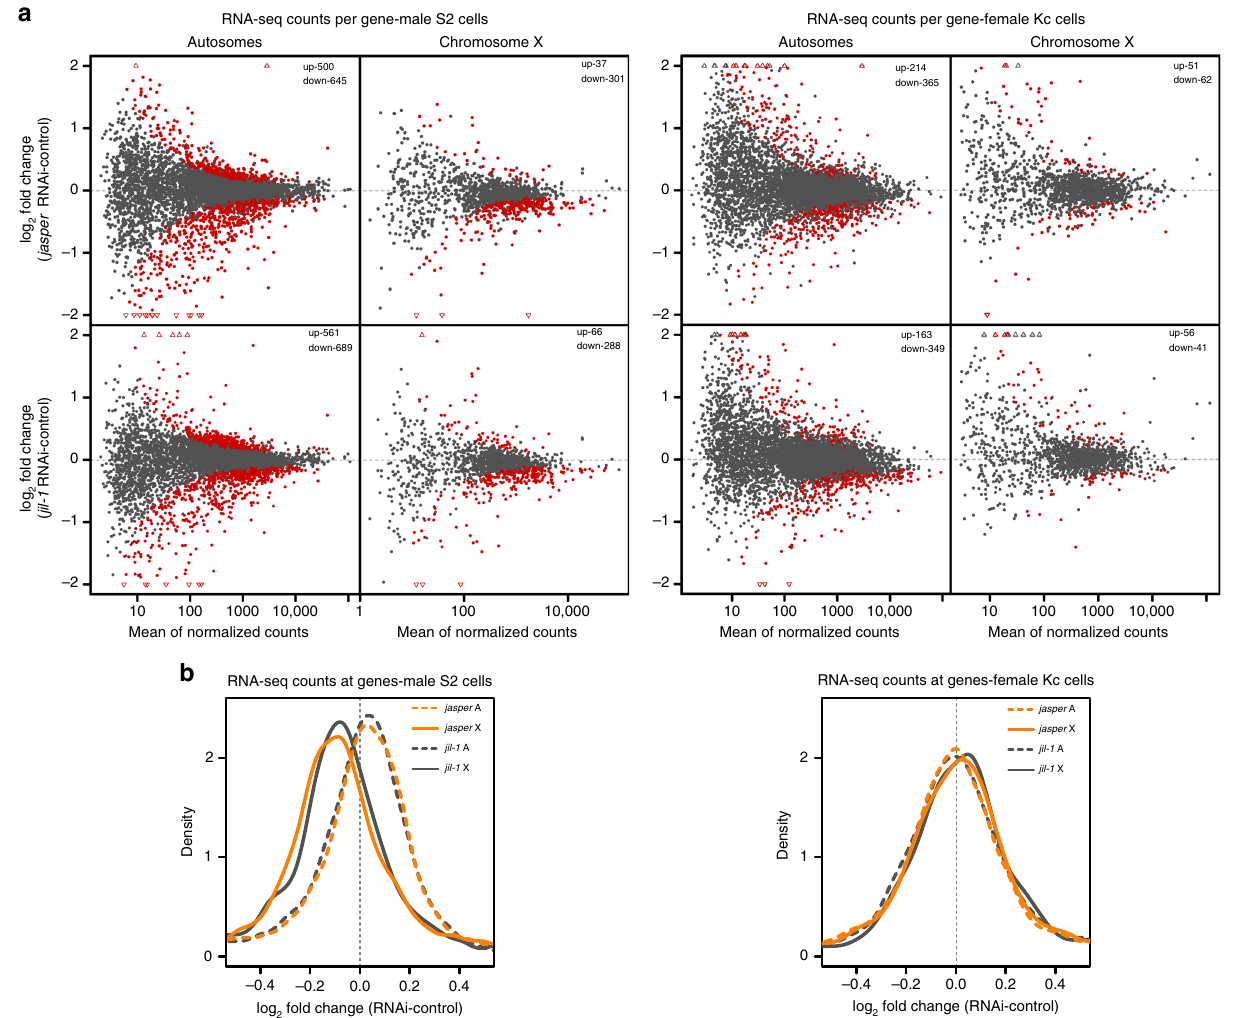
Fig. 5 JIL-1 and JASPer depletion in cells modulates the transcriptional output of genes, especially on the male X chromosome. a MA-plot showing mean log 2 fold-change of RNA-seq counts upon jasper RNAi versus control (upper panel, n = 4) and jil-1 RNAi versus controls (lower panel, n = 5) against mean RNA-seq counts for robustly detected genes at autosomes (left, chromosomes 2L, 2R, 3L, and 3R n = 6833) and X chromosome (right, n = 1441) in male S2 cells (left site). Statistically signi fi cant differentially expressed genes between RNAi and control conditions (fdr < 0.05) are marked in red and the number of signi fi cant genes is indicated on the plot. On the right, mean log 2 fold-change of RNA-seq counts upon jasper RNAi versus control (upper panel, n = 4) and jil-1 RNAi versus controls (lower panel, n = 4) against mean RNA-seq counts for autosomal genes (left, chromosomes 2L, 2R, 3L, and 3R n = 7144) and X chromosomal genes (right, n = 1509) in female Kc cells (left site). b Density plot showing mean log 2 fold-change of RNA-seq counts upon jasper RNAi versus controls ( n = 4) and jil-1 RNAi versus controls ( n = 5) at genes in male S2 cells, in left panel, as in a . X chromosomal genes ( n = 1441) are marked with solid line and autosomal genes (chromosomes 2L, 2R, 3L, and 3R, n = 6833) with dashed line and jasper RNAi additionally in orange. Right panel, mean log 2 fold-change of RNA-seq counts upon jasper RNAi and jil-1 RNAi versus controls ( n = 4 each) at genes in female Kc cells. X chromosomal genes ( n = 1509) and autosomal genes (chromosomes 2L, 2R, 3L, and 3R, n =